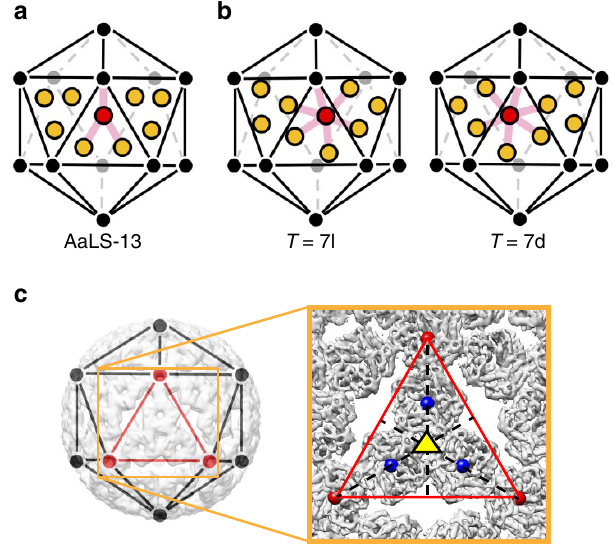
Figure 4 | AaLS-13 capsomer geometry. ( a , b ) Positions of capsomers in AaLS-13 ( a ) compared with their locations in skewed T ¼ 7l and T ¼ 7d viral capsids ( b ). The twelve pentavalent vertices of the icosahedral lattice are shown as black and grey circles. For AaLS-13, pentameric capsomers, projected onto three triangular facets of the lattice, are shown as ochre or red circles; each interacts directly with only three other capsomers, as illustrated by the pink lines from the red unit. For the T ¼ 7l and 7d structures, the corresponding hexavalent sites are projected onto the same facets. In this case, the capsomer units have six neighbours each (shown by the pink lines from the red capsomer). ( c ) Overlay of an icosahedral lattice on the AaLS-13 structure. The cryo-EM density map viewed along one of the three-fold symmetry axes (yellow triangle) is shown magnified in the box on the right. Centroids of pentamers at five-fold symmetry axes are shown as red spheres. Centroids of pentamers projected onto an equilateral triangular facet of the icosahedral lattice are shown as blue